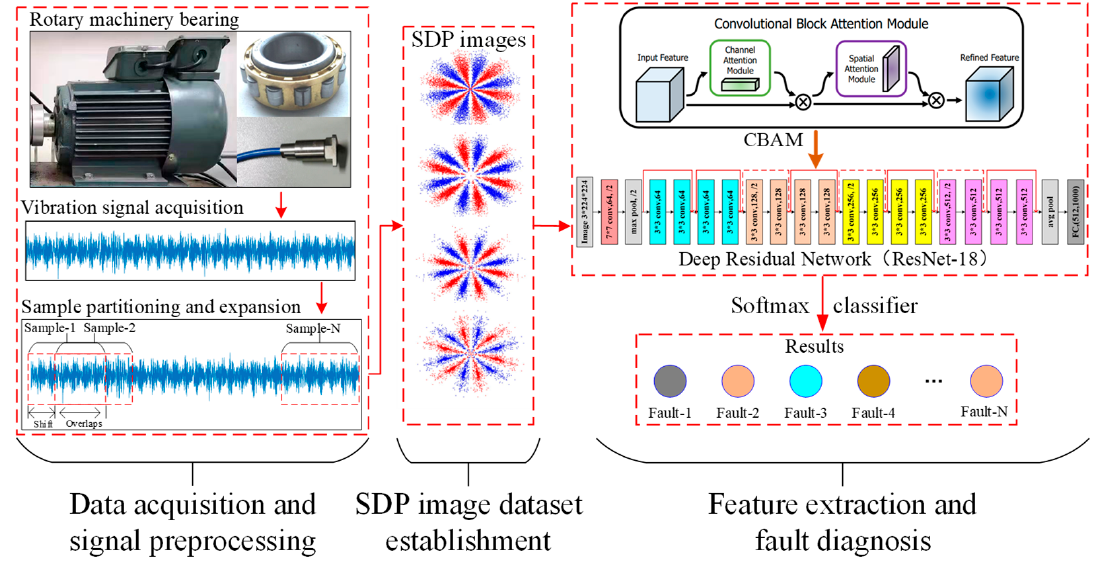
Figure 5. The RBFD structure using SDP and CBAM-DRN.